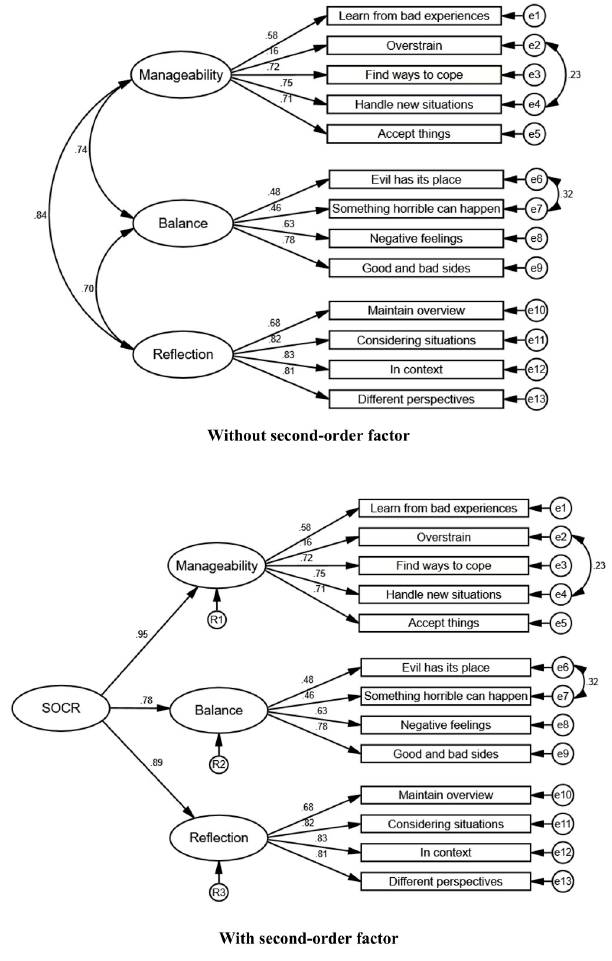
Fig 1. Factor structure of the modified three-factor model (with and without the second-order factor) with factor loadings and co-variances.